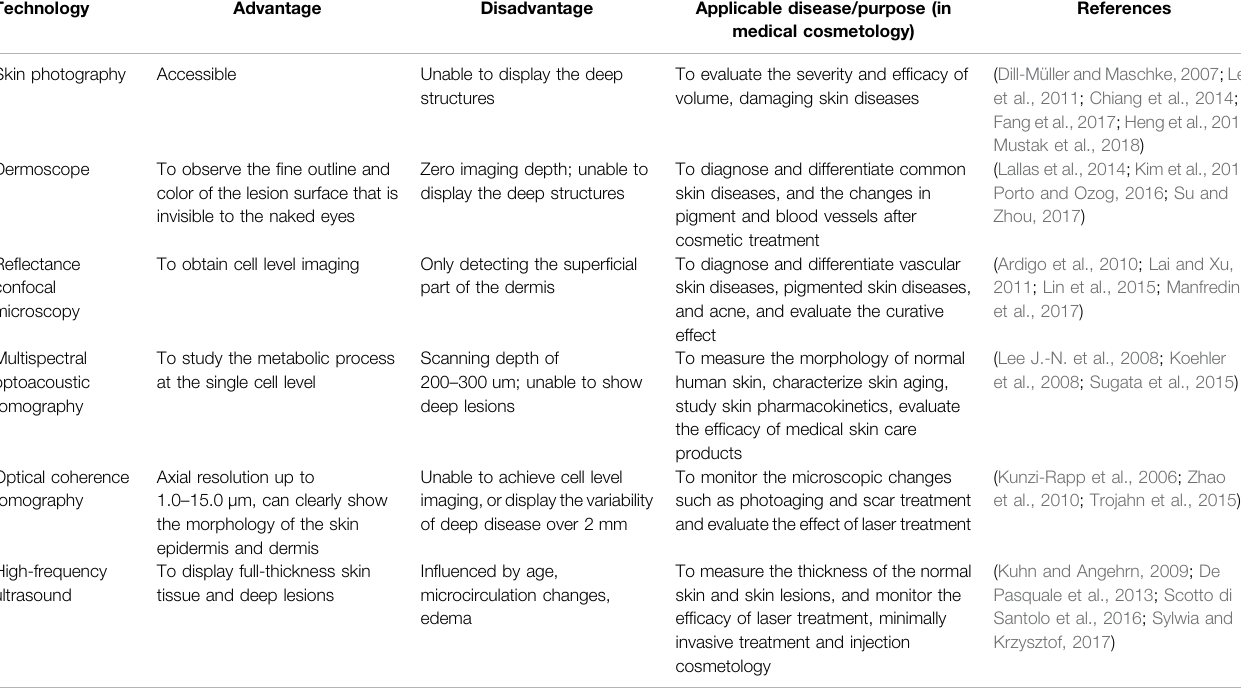
TABLE 1 | Comparison of the advantages and disadvantages among the conventional skin imaging